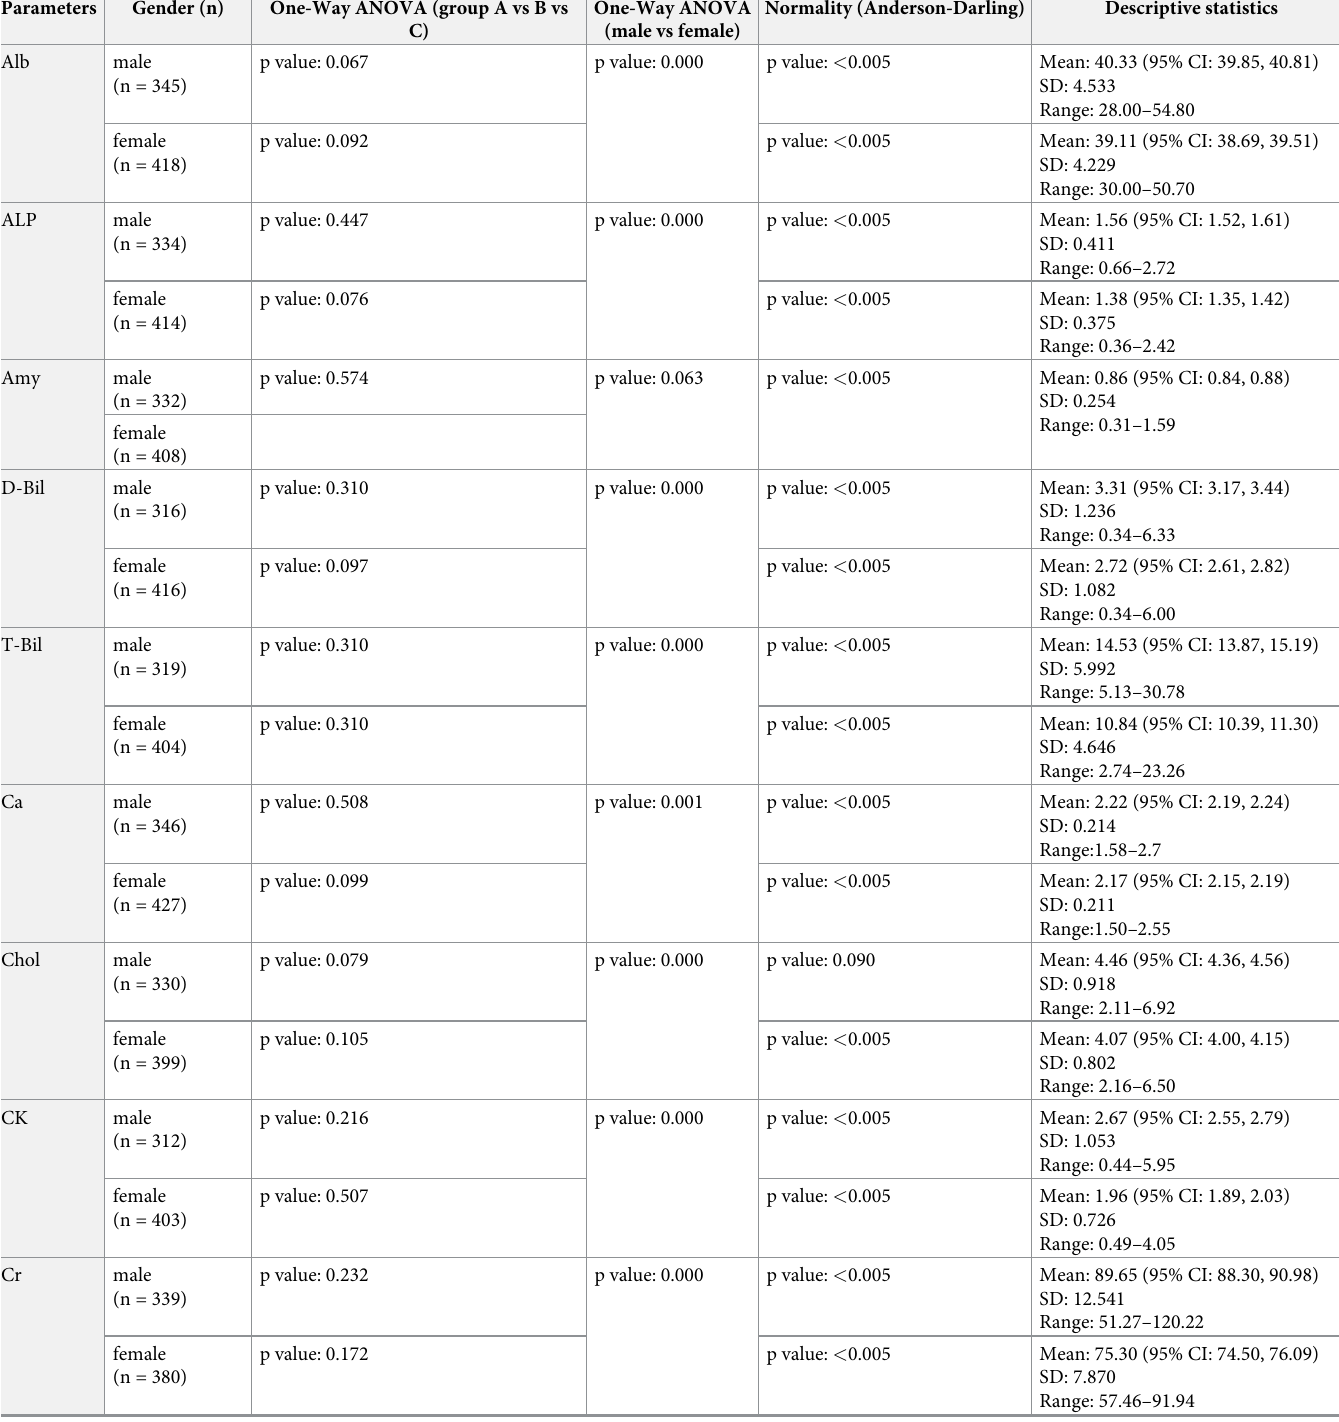
Table 4. The statistical analysis of clinical chemistry reference values. The table shows the p-value of one-way ANOVA between sex, age group categories under each sex and descriptive statistics for each clinical chemistry parameter. Parameters Gender